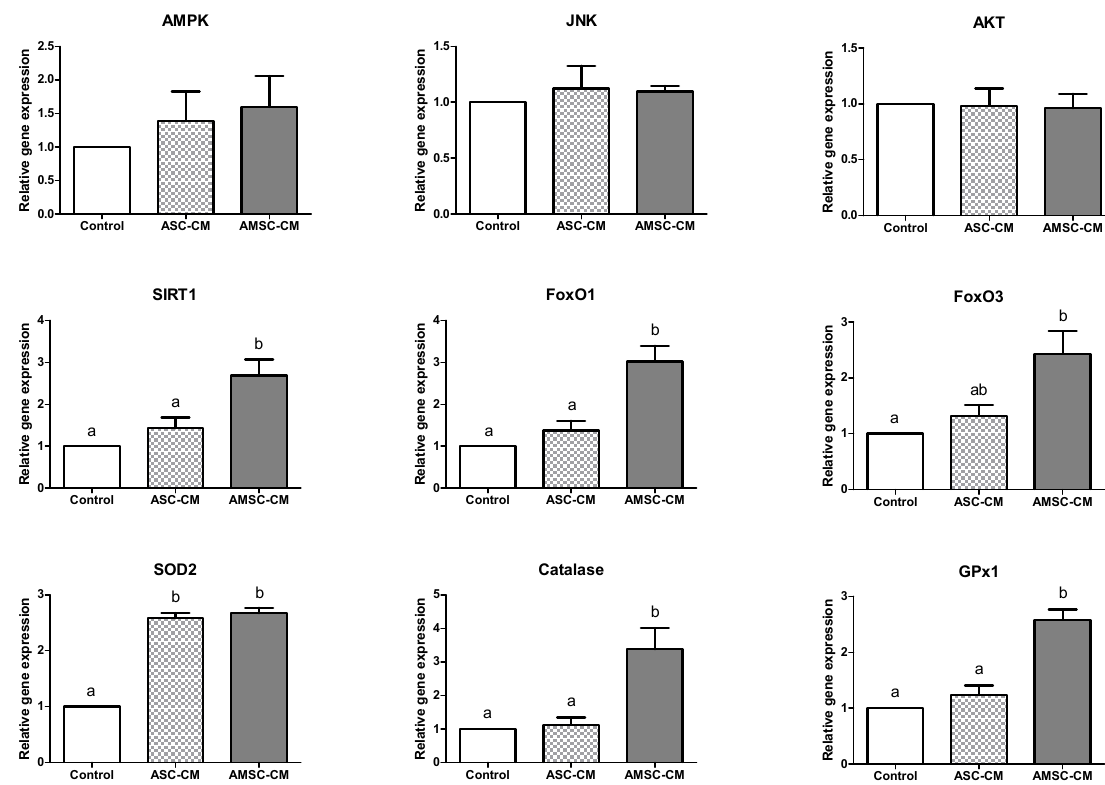
Figure 2. Relative antioxidant gene expression in blastocysts cultured in control, human adipose-derived mesenchymal stem cell conditioned medium (ASC-CM) and amniotic membrane-derived mesenchymal stem cell conditioned medium (AMSC-CM). Data are normalized to housekeeping gene 18S rRNA and presented as mean ± standard error of the mean (SEM). Superscript letters in each column indicate significant differences ( p < 0.05).